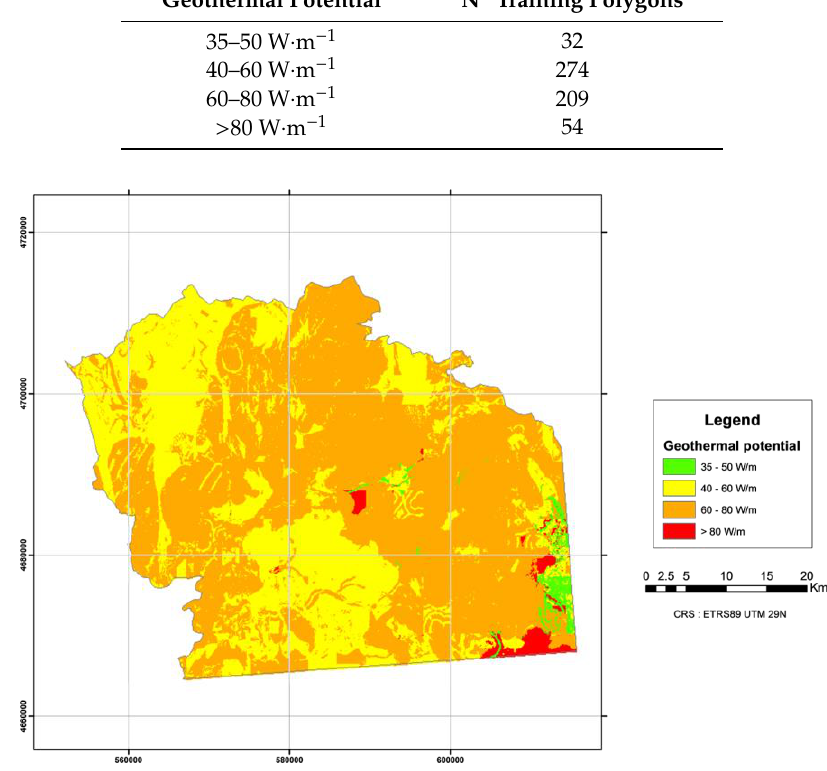
Figure 10. Geothermal potential map.